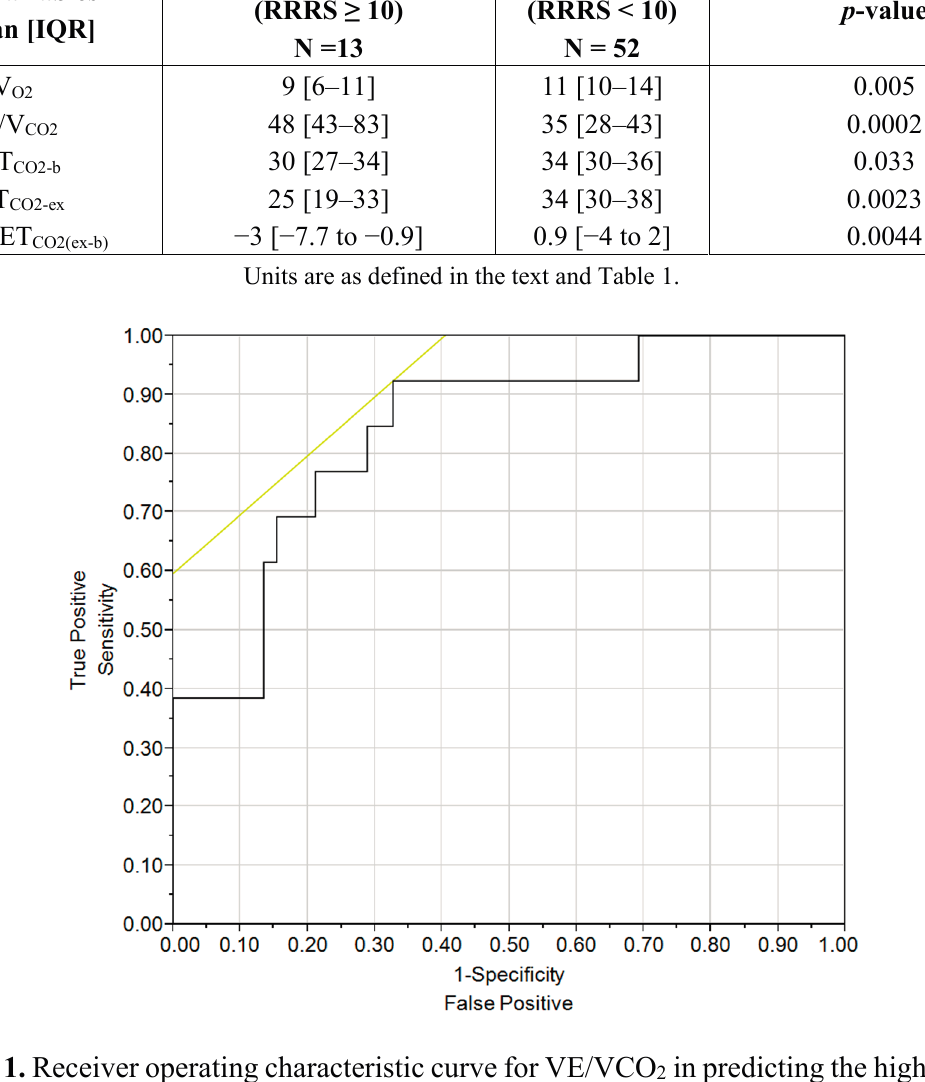
Table 3. SET parameters comparing the highest risk group (RRRS ≥ 10) versus the lowest risk group. SET Variables